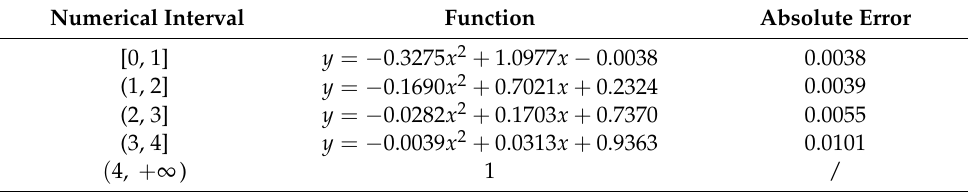
Table 2. Fitting function at different